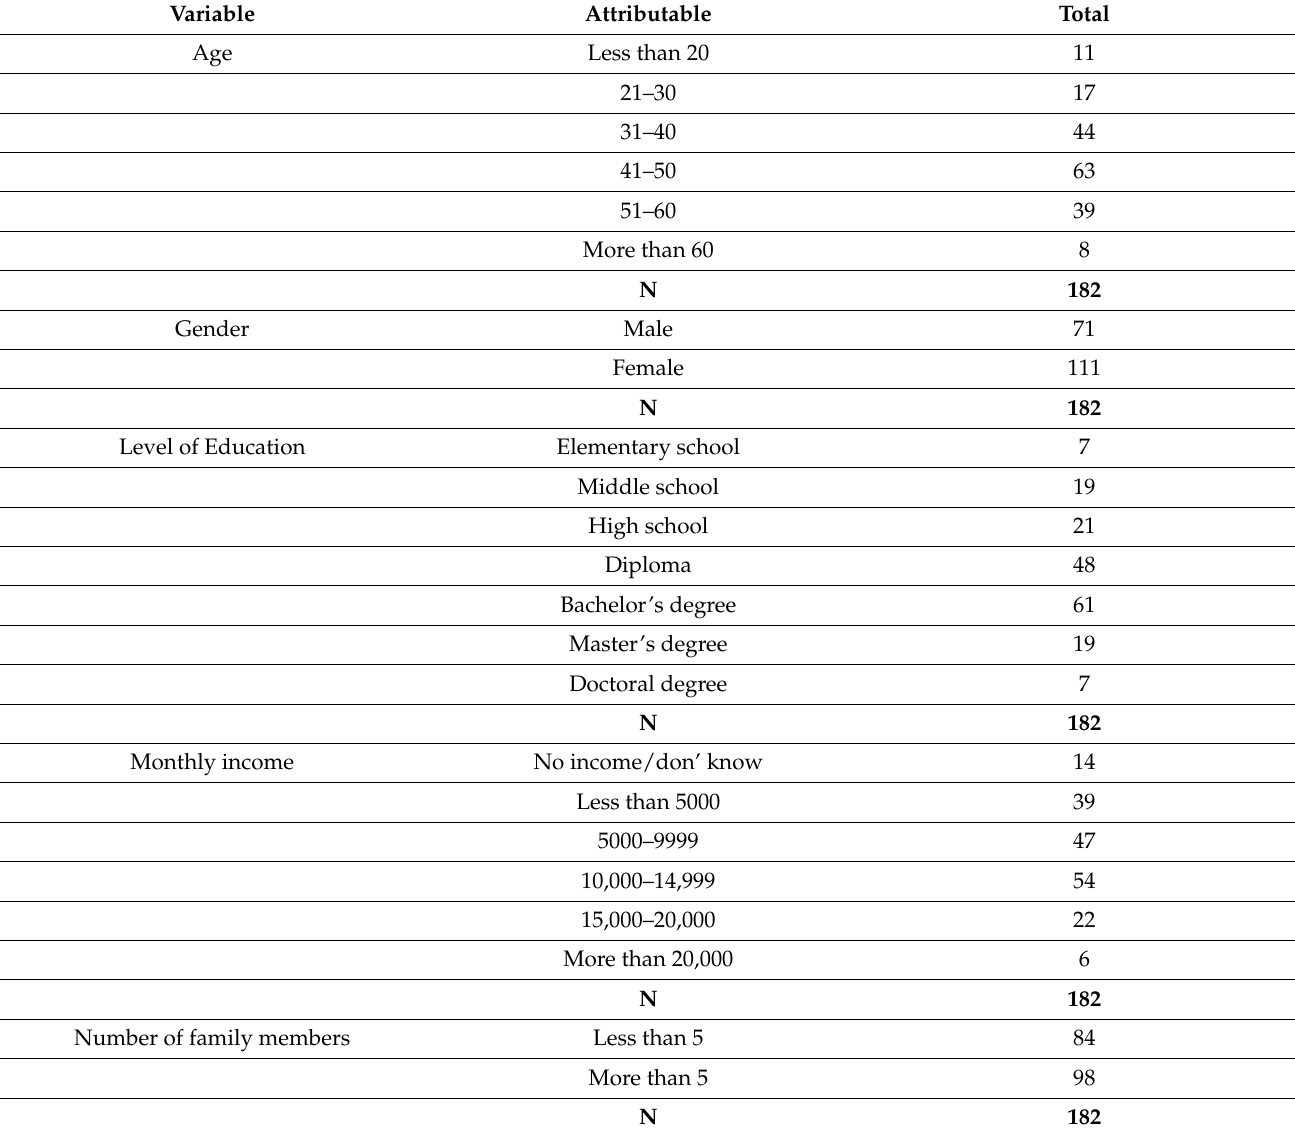
Table 1. Summary of the available demographic attributes of the